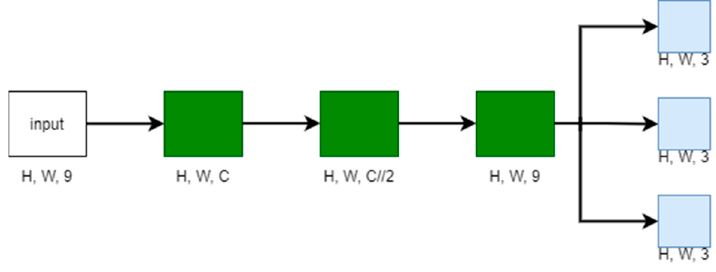
Figure 6. Architecture of proposed SB block.